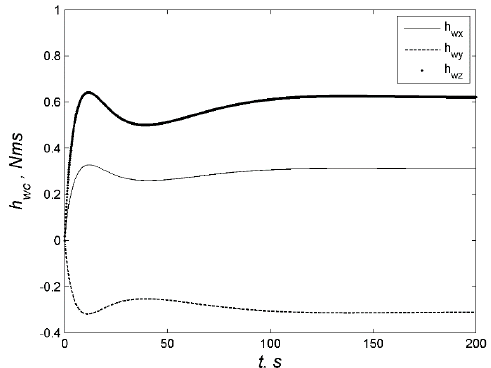
Figure 8. Angular momentum of reaction wheels.